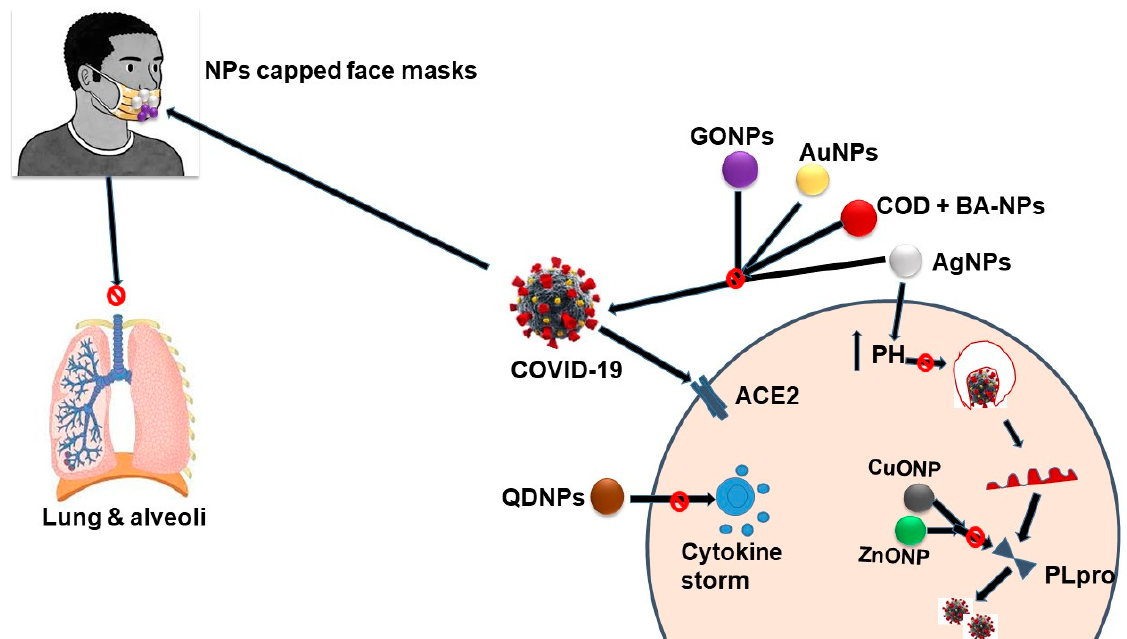
Figure 4. The role of nanomaterials for prevention and inactivation of COVID-19 infection. CuONP is a copper oxide nanoparticle, ZnONP is a zinc oxide nanoparticle, cBA-NP is a boric acid nanoparticle, GONP is a graphene oxide nanoparticle, COD-NP is a carbon oxide nanoparticle, AuNP is a gold nanoparticle, AgNP is sliver nanoparticle, and QDs is quantum dots. Table 3. Nanoparticles and their mechanism of targeting and detecting SARS-CoV-related viruses. Nanomaterials The Mechanism of